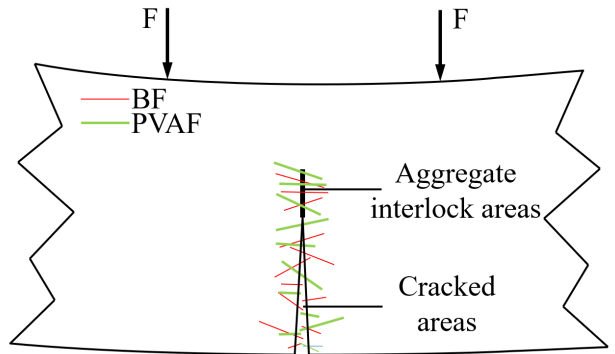
Figure 16. The effect mechanism of hybrid fiber on concrete flexural damage.